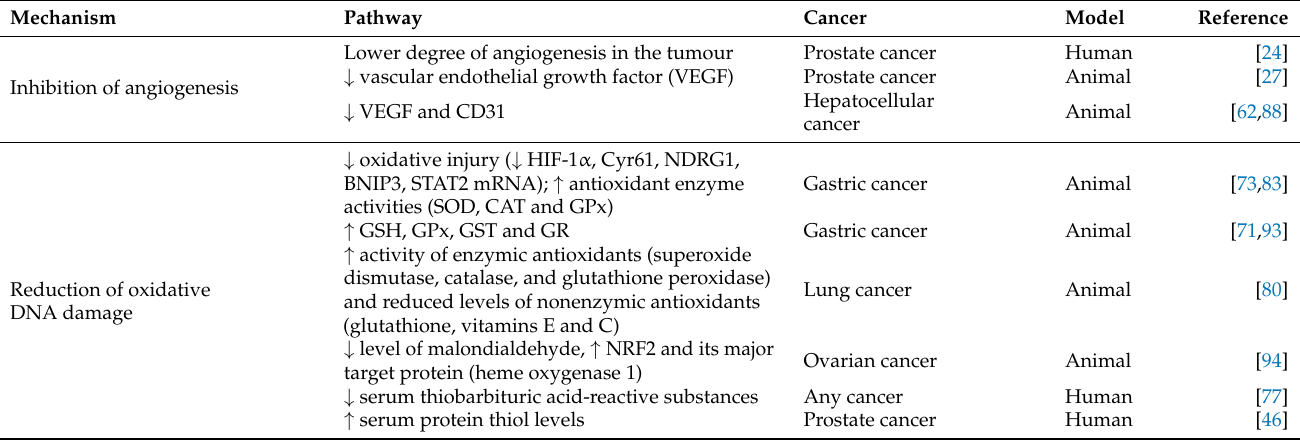
Table 1. Mechanisms of lycopene antitumour activity identified in in vivo